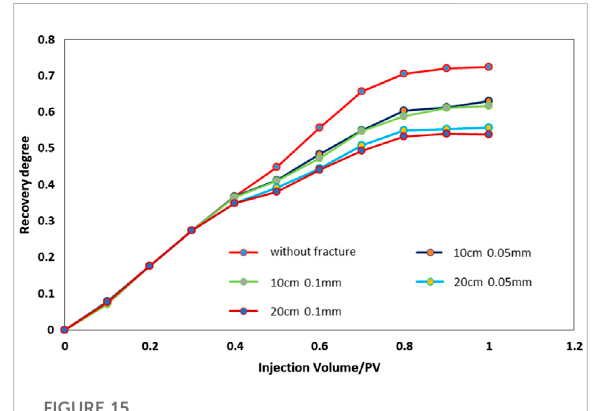
FIGURE 15 Comparison of the recovery degree of the different